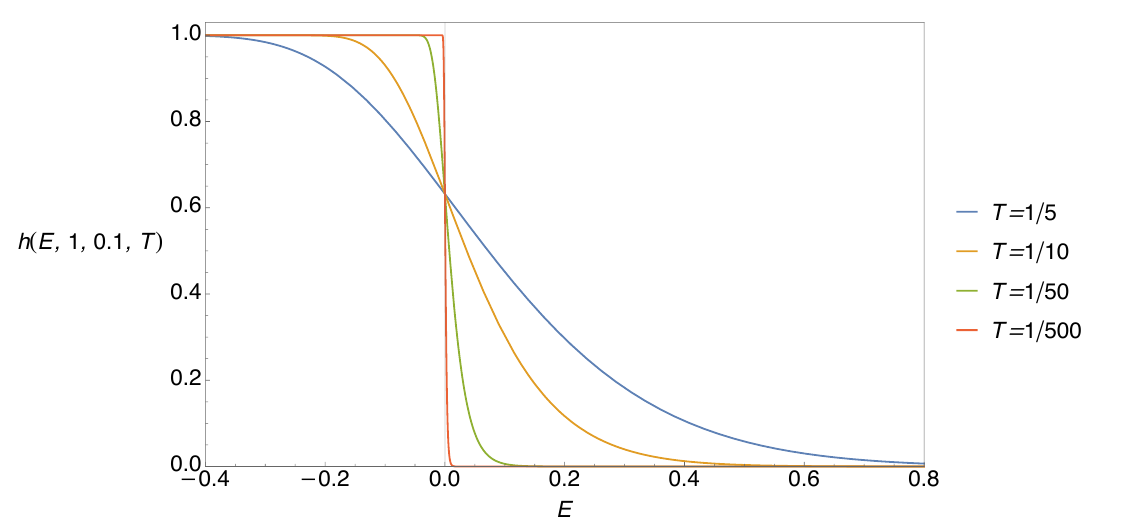
Figure 12. We plot h ( E, x, λ, T ) near x = 1 and at λ = 0 . 1 . Here h ( E, x, λ, T ) is increasingly steeper as temperature T